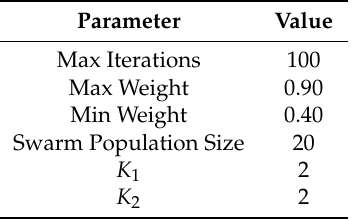
Table 3. Particle swarm optimization (PSO) parameters.